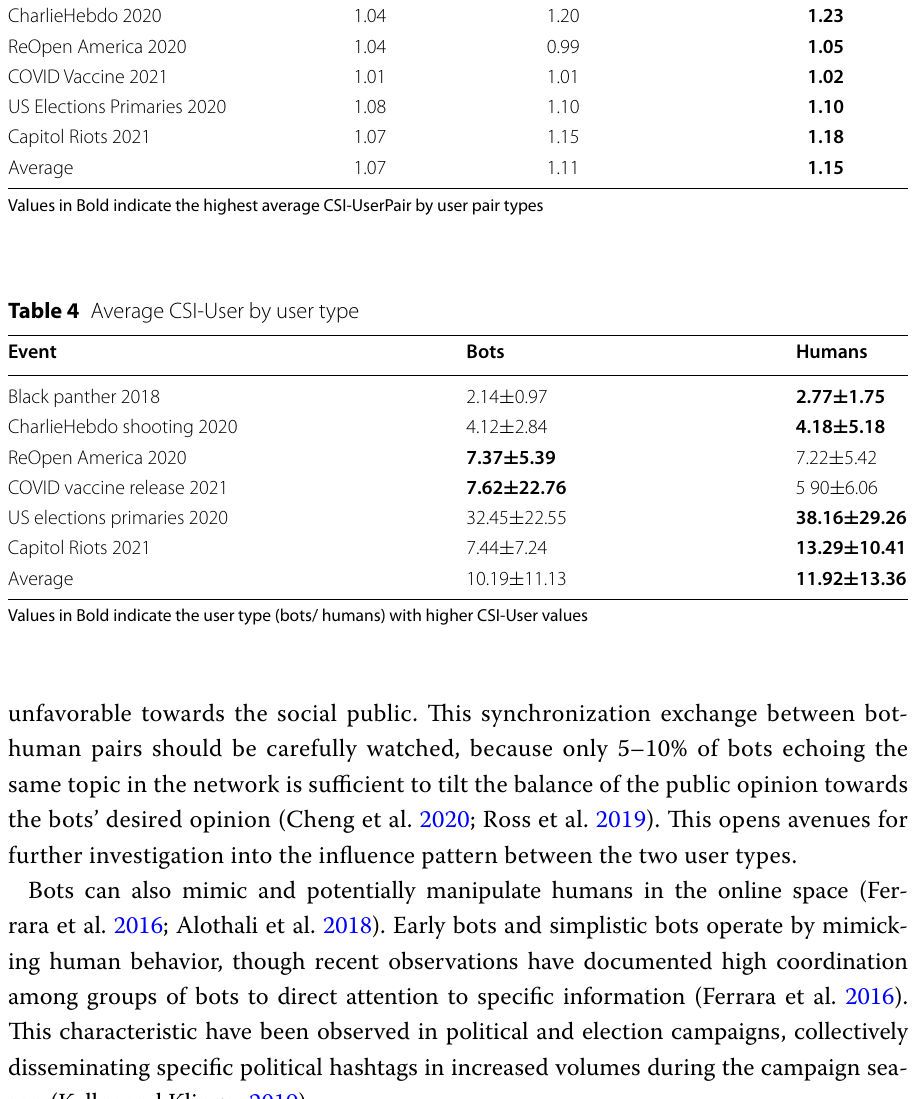
Table 3 Average CSI-UserPair by user-user pair types Event